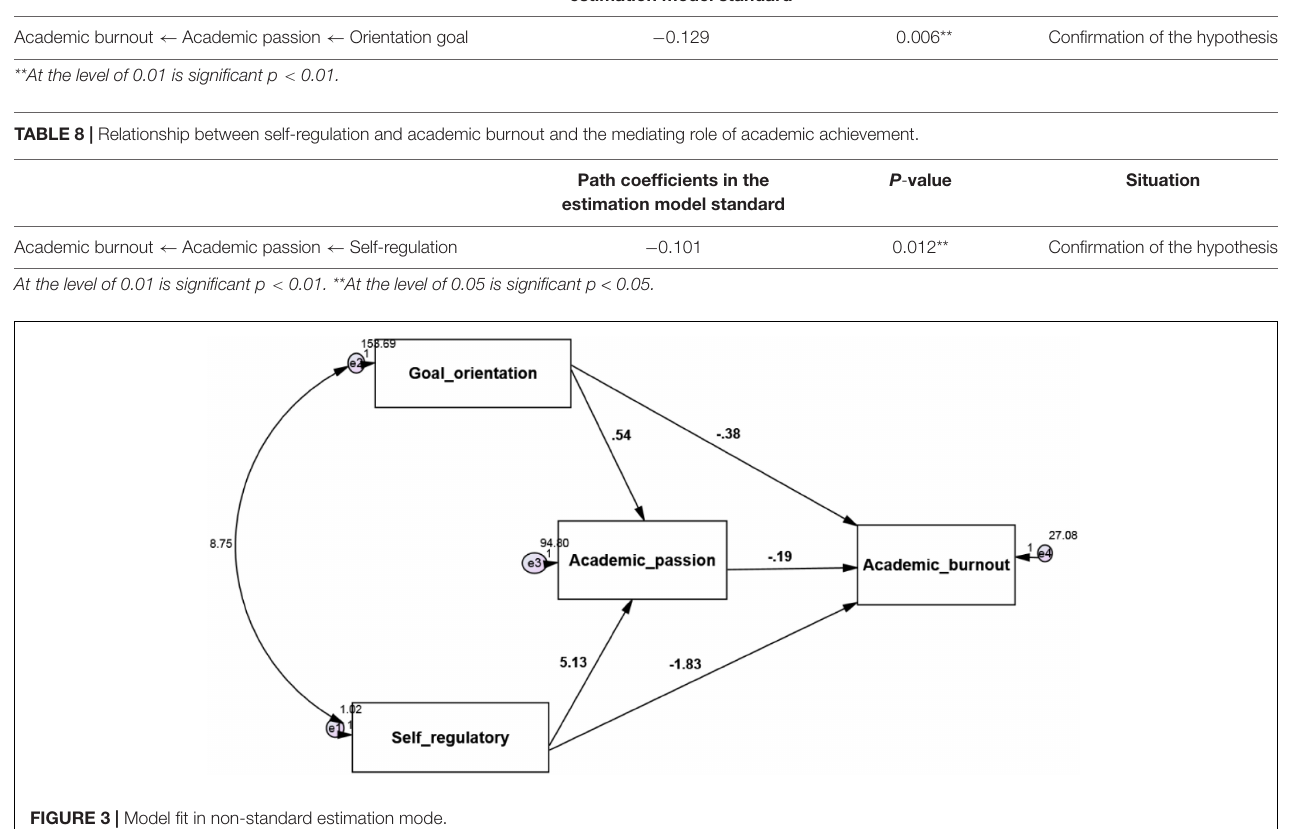
FIGURE 3 | Model fit in non-standard estimation